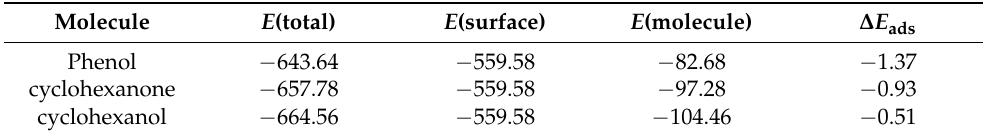
Table 3. The calculated phenol, cyclohexanone, cyclohexanol adsorption energy on Ru (002) surface, unit: